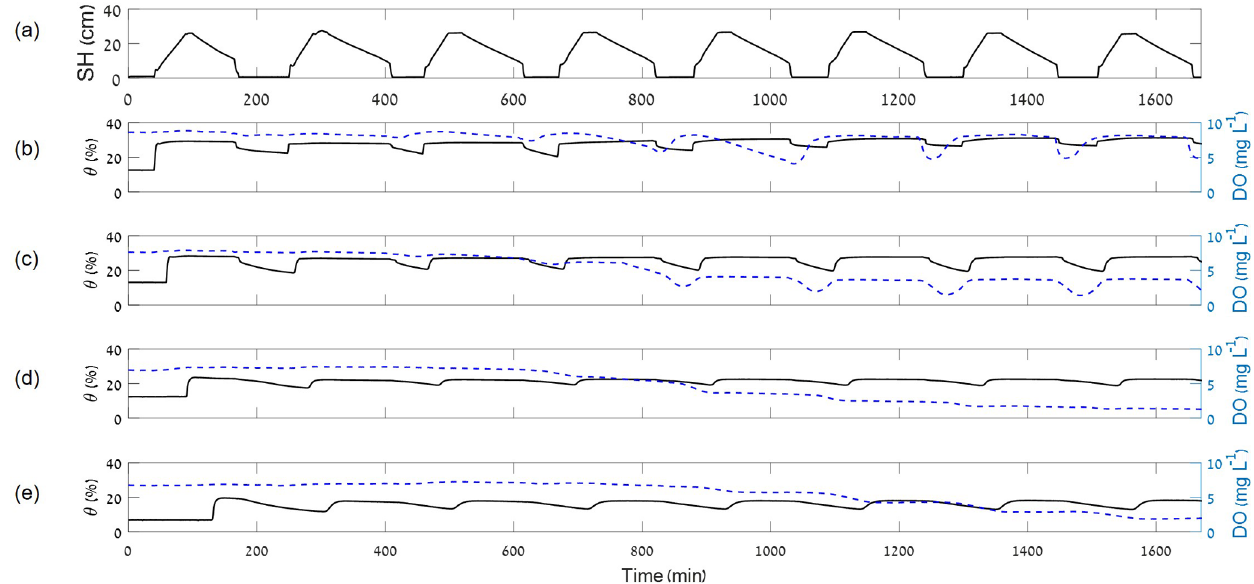
Figure 2. Surface head (SH; panel a ), water content ( θ ) and DO over time at depths of 25, 75, 175 and 275cm below soil surface (panels b , c , d and e , respectively) during